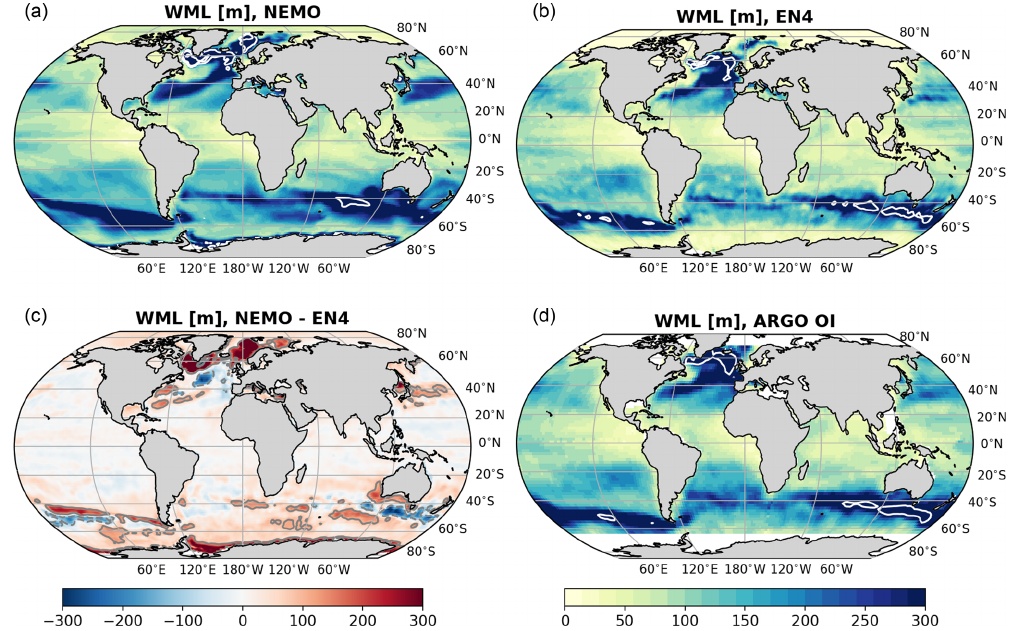
Figure 1. Winter (i.e. temporal maximum) mixed-layer depth (m) between 2004 and 2017 in NEMO (a) , EN4 (b) , and Argo (d) , and the difference between NEMO and EN4 (c) . Note that the temporal resolution is monthly for NEMO and EN4, whereas it is every 10d for Argo.